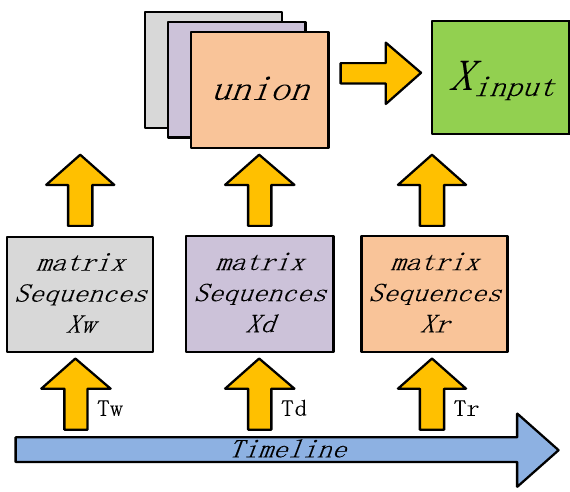
Figure 4. Multi-level temporal model